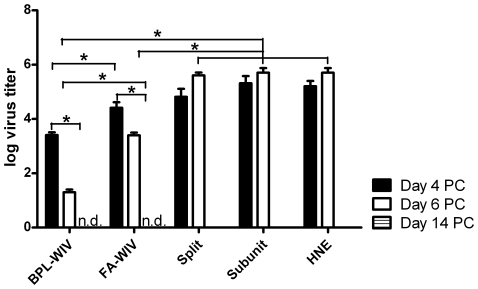
Virus titers in the lungs of vaccinated mice after heterologous challenge.Virus titers in the lungs of mice vaccinated with the indicated formulations were measured at days 4 and 6 after challenge. Bars represent mean titer±SEM of three mice. Mice vaccinated with either BPL-WIV or FA-WIV had lower virus titers in the lungs at both days 4 and 6 compared to the titers in mice vaccinated with split vaccine, subunit vaccine or HNE buffer (p<0.05 for all comparisons; Mann-Whitney U test). Furthermore, in mice vaccinated with WIV, virus titers were lower at day 6 compared to titers at day 4 post-challenge (p<0.05; Mann-Whitney U test). Finally, significantly lower titers were observed in mice vaccinated with BPL-WIV compared to titers in mice vaccinated with FA-WIV, both at day 4 and day 6 (p<0.05; Mann-Whitney U test). No virus was detected in surviving mice at day 14 after challenge (n.d., not detectable).